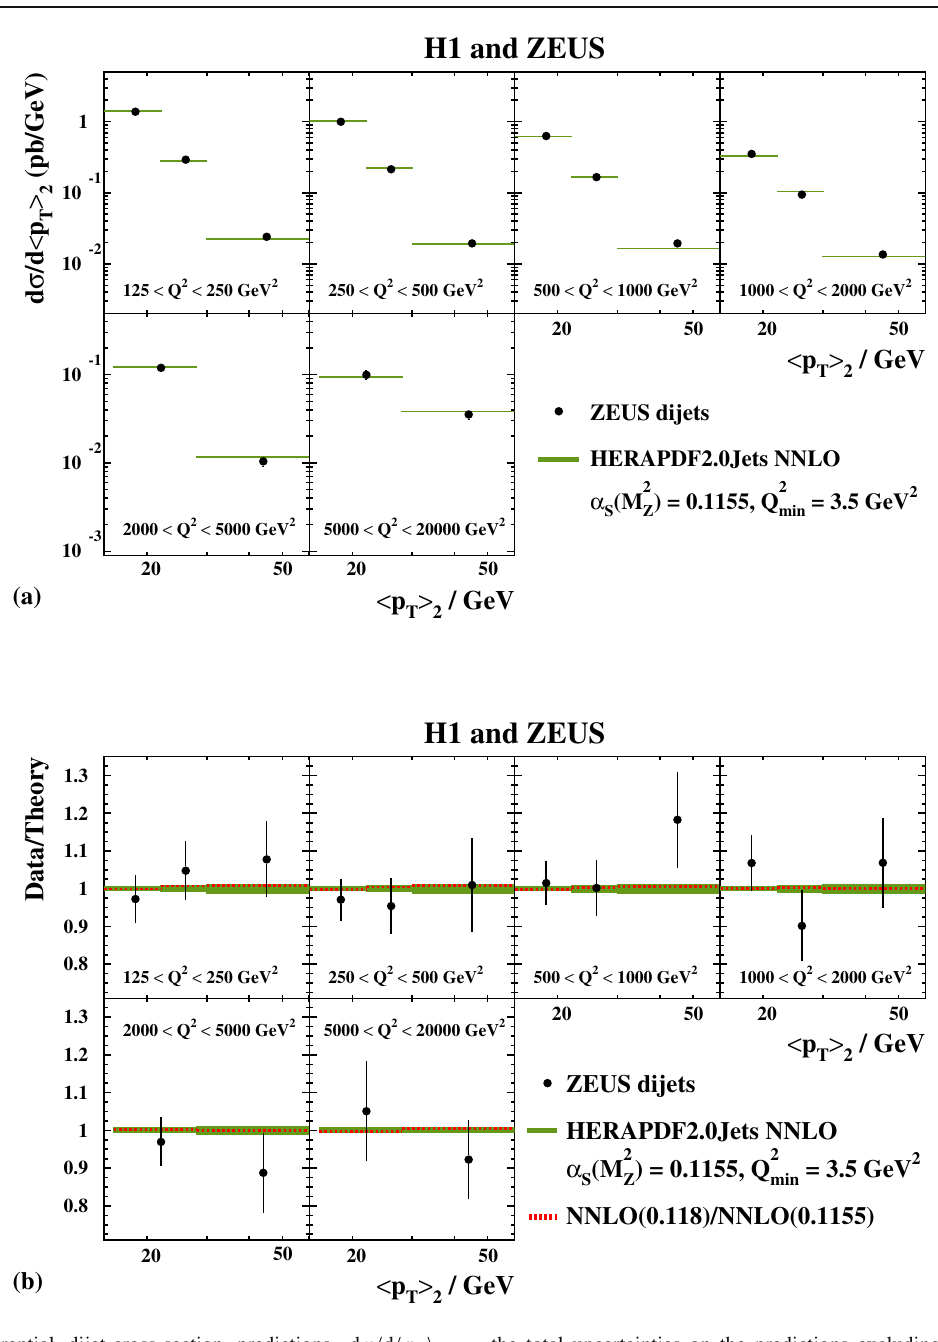
the total uncertainties on the predictions excluding scale uncertain- ) = 0 . 1155 in bins ties; the bands are so narrow that they mostly appear as lines. Error Z bars indicate the full uncertainties on the data and are smaller than the symbols in ( a ). In b , the ratio of predictions based on HERA- ) = 0 . 118 and α ( M 2 ) = 0 . 1155 is PDF2.0Jets NNLO with α s ( M 2 s Z Z also